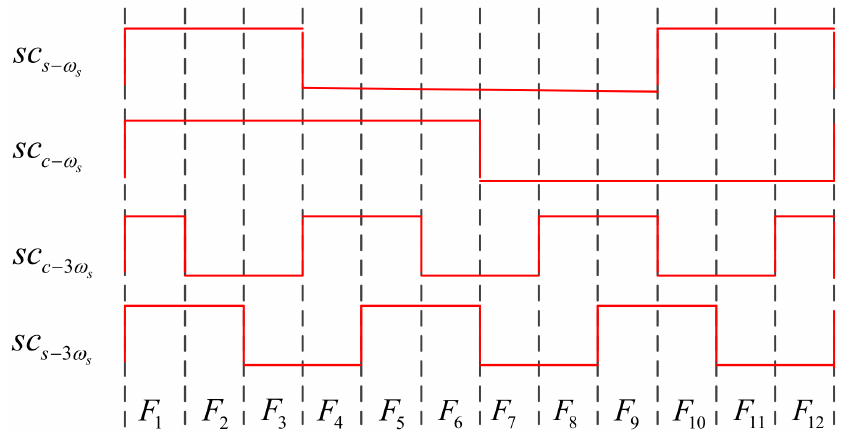
Figure 3. The sub-carrier state of the multiplexing signal.